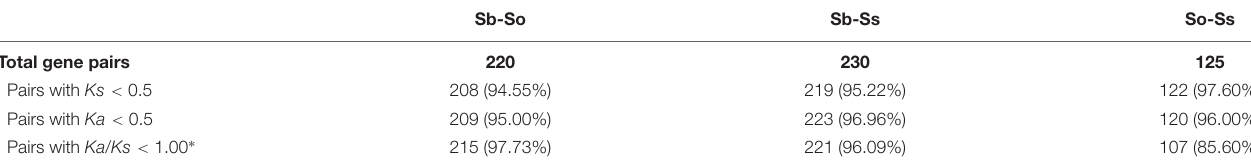
TABLE 2 | Number of syntenic gene pairs used for calculation of Ks , Ka , and Ka / Ks ratios. Sb-So Sb-Ss So-Ss Total gene pairs 220 Pairs with Ks < 0.5